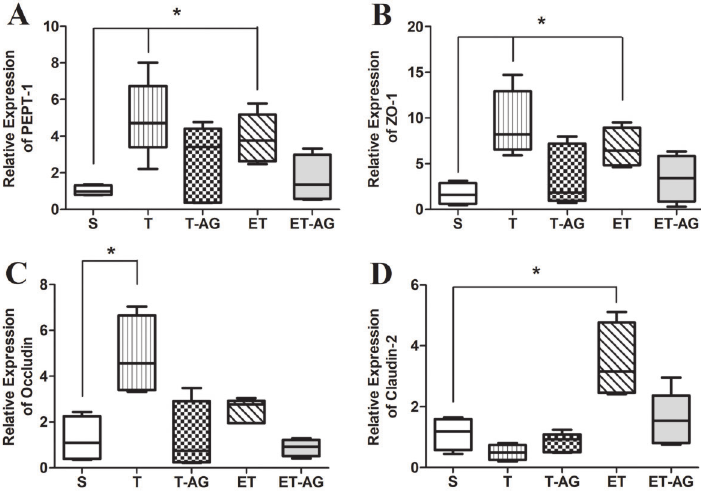
Figure 3. Relative mRNA expression of ( A ) peptide transporter-1 (PEPT-1), ( B ) zonula occludens-1 (ZO-1), ( C ) occludin, and ( D ) claudin-2. Animals were subdivided into 5 groups: sedentary without supplementation (S), trained animals without supplementation (T), trained animals supplemented with alanyl-glutamine (T-AG), trained animals subjected to an exhaustive test without supplementation (ET), and trained animals subjected to an exhaustive test and supplemented with alanyl-glutamine (ET-AG). The data are reported as median, minimum and maximum, and interquartile range (n=8). *P o 0.05 compared with the S group (Mann-Whitney test).